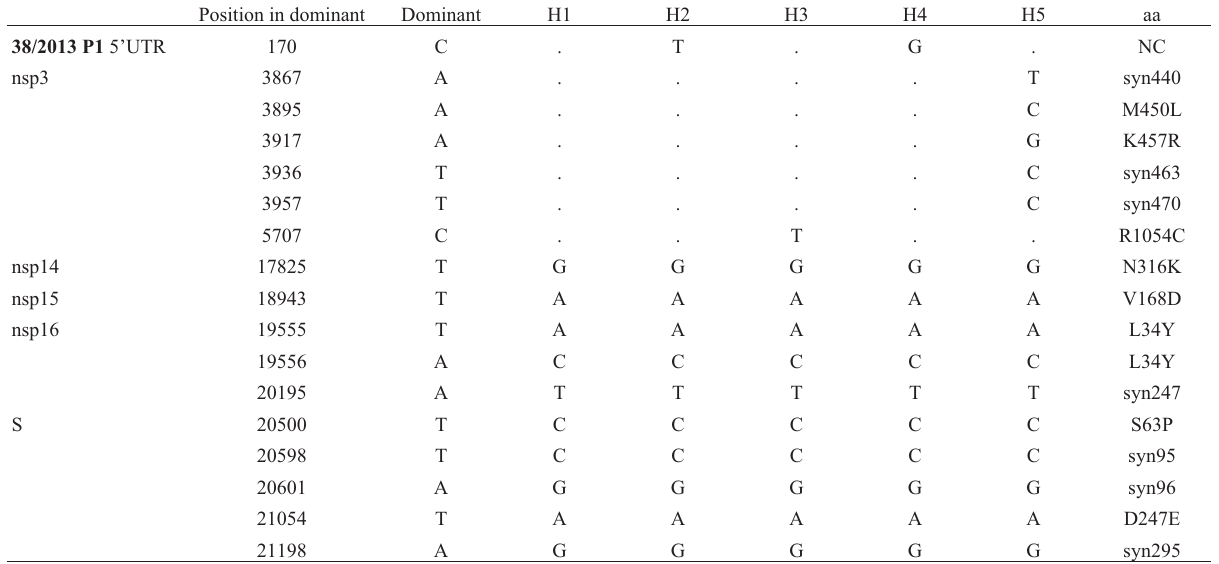
Table 1 - Haplotypes (H) found for passages 1 (P1) and 3 (P3) of AvCoV strain 38/2013 and 3 (P3) of strain 23/2013 for each position based on the domi- nant sequence for each passage and the respective (if any) amino acid substitution; syn=synonymous mutations; *= stop codon; NC=non-coding region; del=deletion; #=haplotype number not found; aa= aa synonymous (syn) or non-synonymous mutations and the positions regarding the specific protein; Dots indicate identity with the dominant sequence. Same haplotype numbers do not indicate identical haplotypes for different strains and passages. Position in dominant Dominant H1